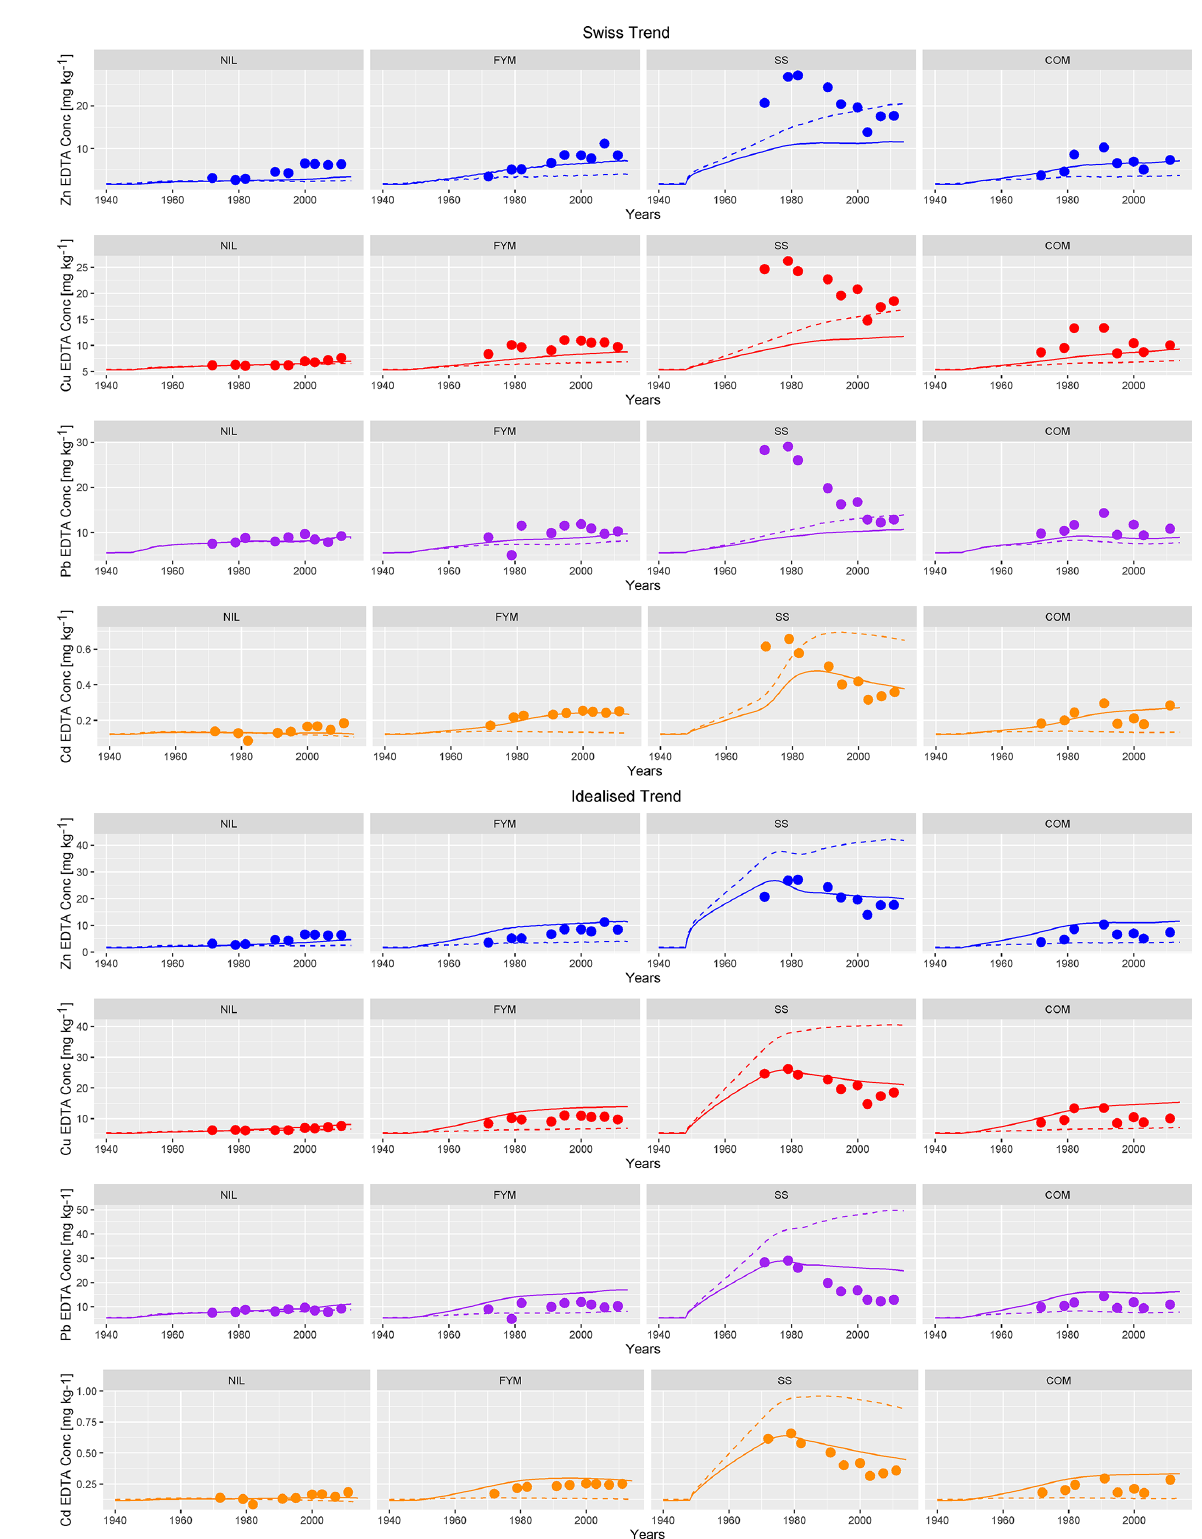
Figure 5. Observed EDTA-extractable concentrations (bullets), simulated labile concentrations with mixing (solid line) and without mixing (dashed line) with Swiss trend inputs (top) and idealised trend inputs (bottom) for Zn, Cu, Pb, Cd in ZOFE topsoil (0–20cm) for the treatments NIL, FYM, SS and